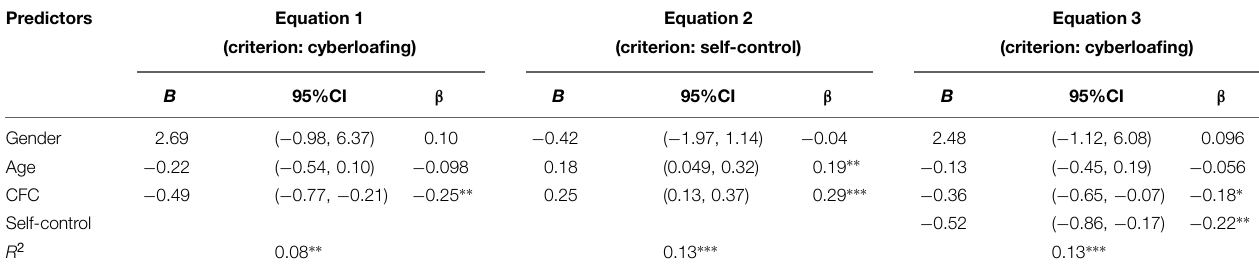
TABLE 2 | Test the mediation effects of self-control on cyberloafing ( N = 210). Predictors